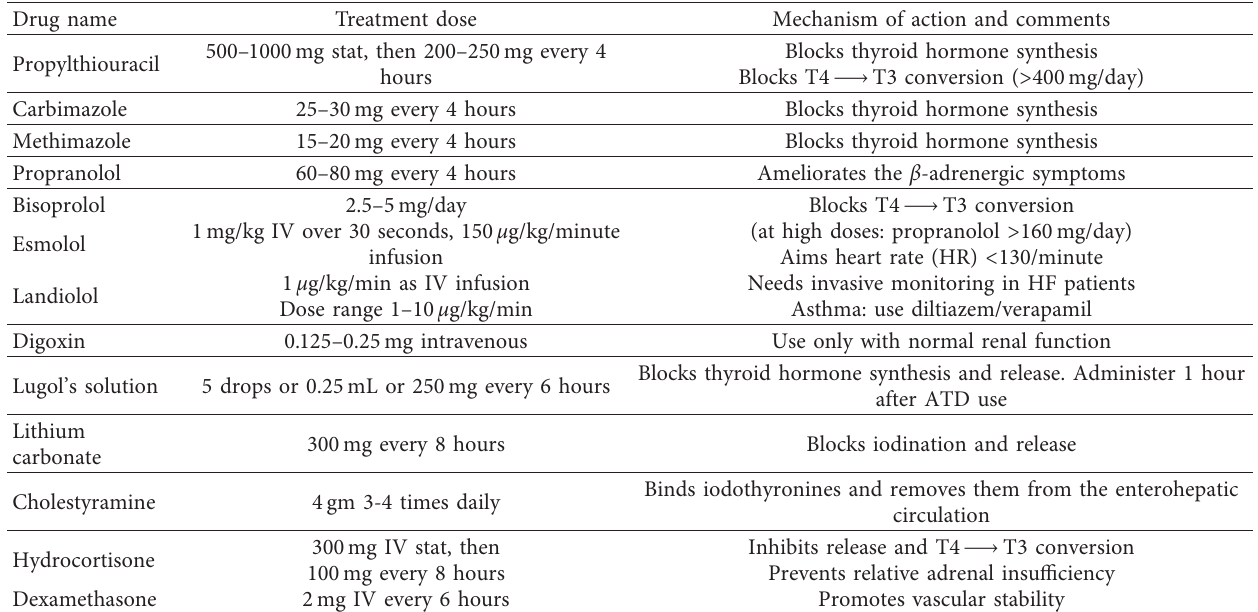
Table 3: Drugs used in the management of thyroid storm [3, 6,